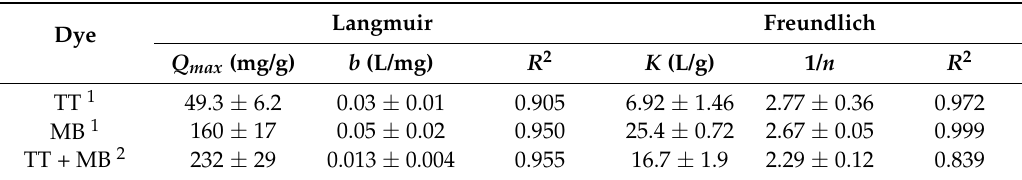
Table 4. Langmuir and Freundlich equilibrium parameters (±SD) obtained by non-linear regression analysis for TT and MB biosorption by V. dubyana biomass in binary system TT + MB.